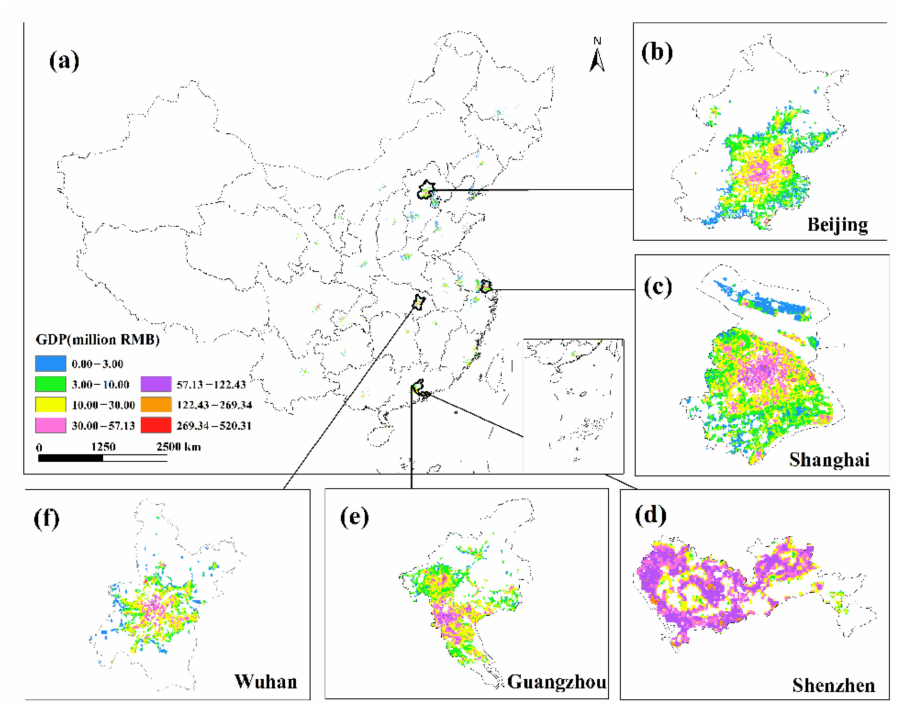
Figure 13. The spatial distribution of the total GDP of the secondary and tertiary industries in June 2020. ( a ) The spatial distribution of the total GDP in 34 Chinese cities; ( b ) Beijing; ( c ) Shanghai; ( d ) Shenzhen; ( e ) Guangzhou; ( f )